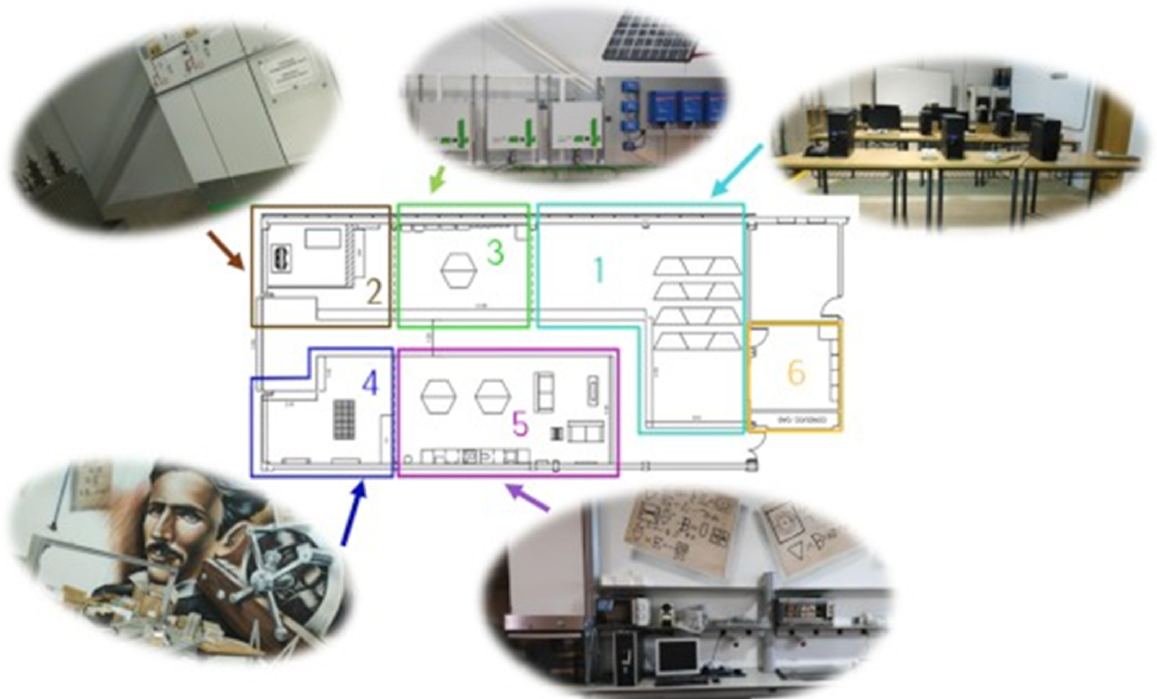
Figure 1. Laboratory layout.